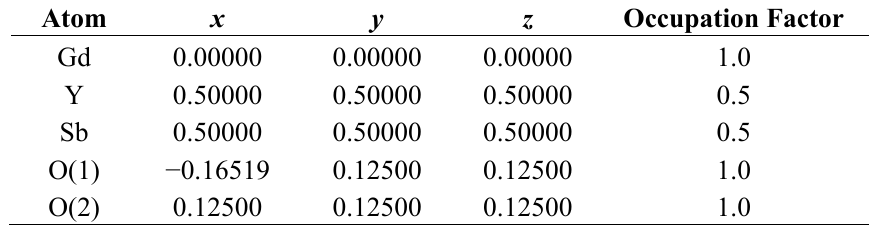
Figure 1. X-ray powder diffraction pattern of Gd 2 FeSbO 7 , Gd 2 InSbO 7 or Gd 2 YSbO 7 prepared by a solid-state reaction method at 1250 °C, 1320 °C or 1320 °C. Table 1. Structural parameters of Gd 2 YSbO 7 prepared by solid-state reaction method. x , y and z refer to the position coordinates of different atoms in one unit cell,